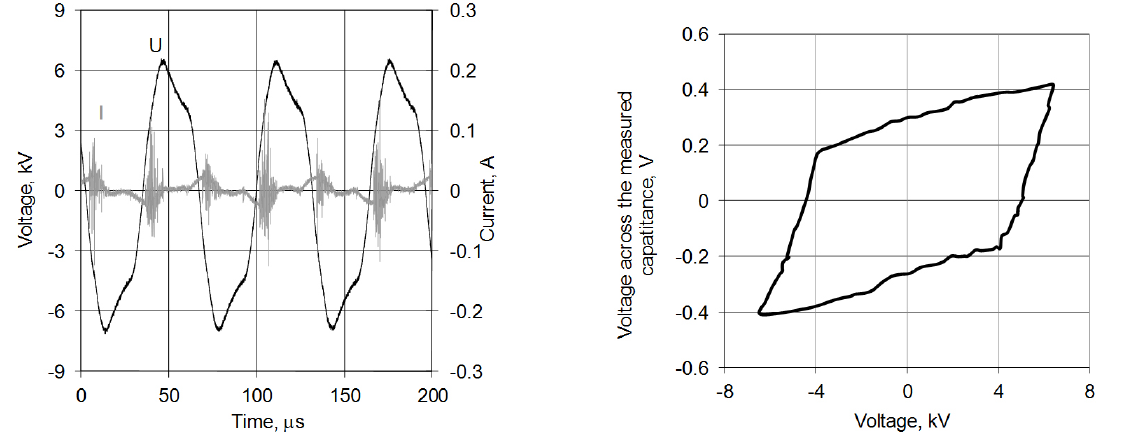
Figure 3 : Traces of pulses voltage and current for the barrier reactor and Lissajous-figure.